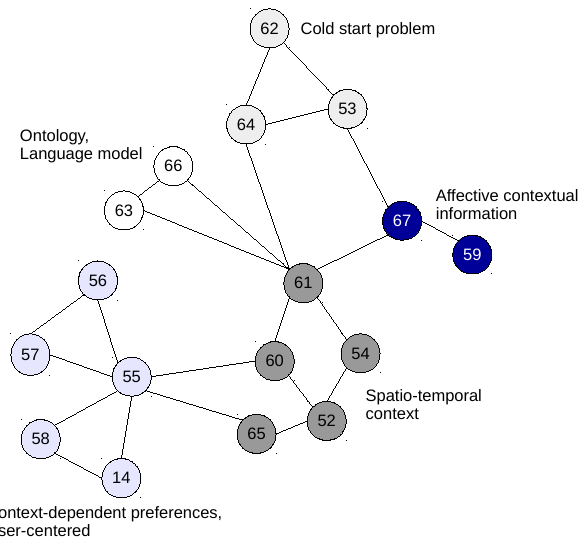
Figure 5. Overview of the similarity relationship graph between papers selected in the systematic review and its organization in groups of topics. Each paper is a graph node and the node number indicates the bibliographic reference number. Two similar papers are connected by an edge. Colors define groups of